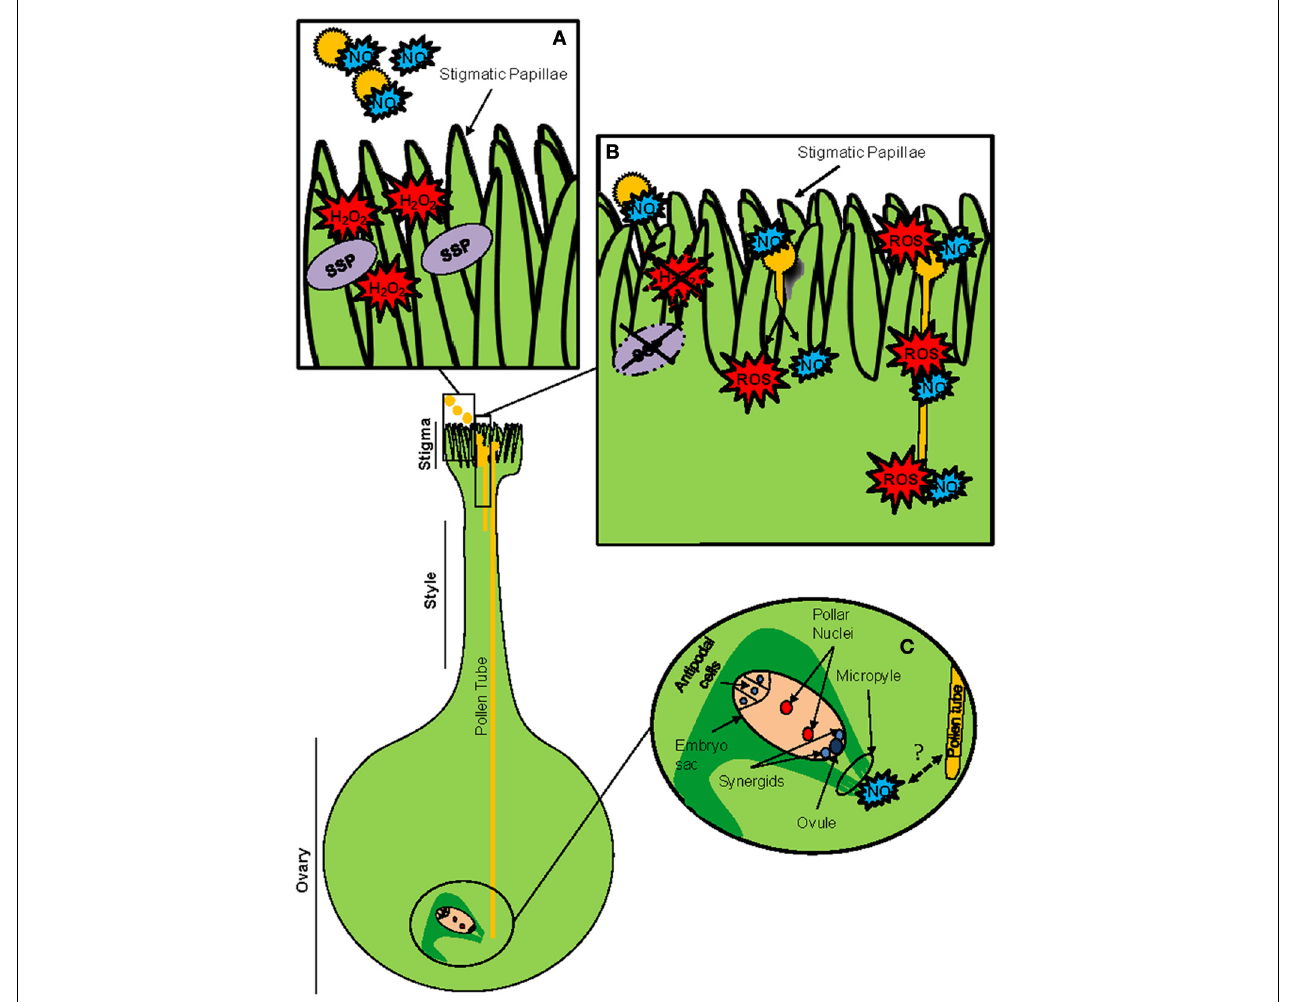
FIGURE 1 | ROS/NO are implicated in plant reproduction signaling. Model gynoecium of an Angiosperm. (A) Receptive stigma at high magnification, before pollen-pistil interaction. Pollen grains are active NO producers, while the receptive stigma papillae generate large quantities of H 2 O 2 and display enhanced peroxidase activity, in some cases in the form of stigma-specific peroxidase (SSP). (B) Stigma and pollen grains during diverse phases of their interaction. Both the enhanced